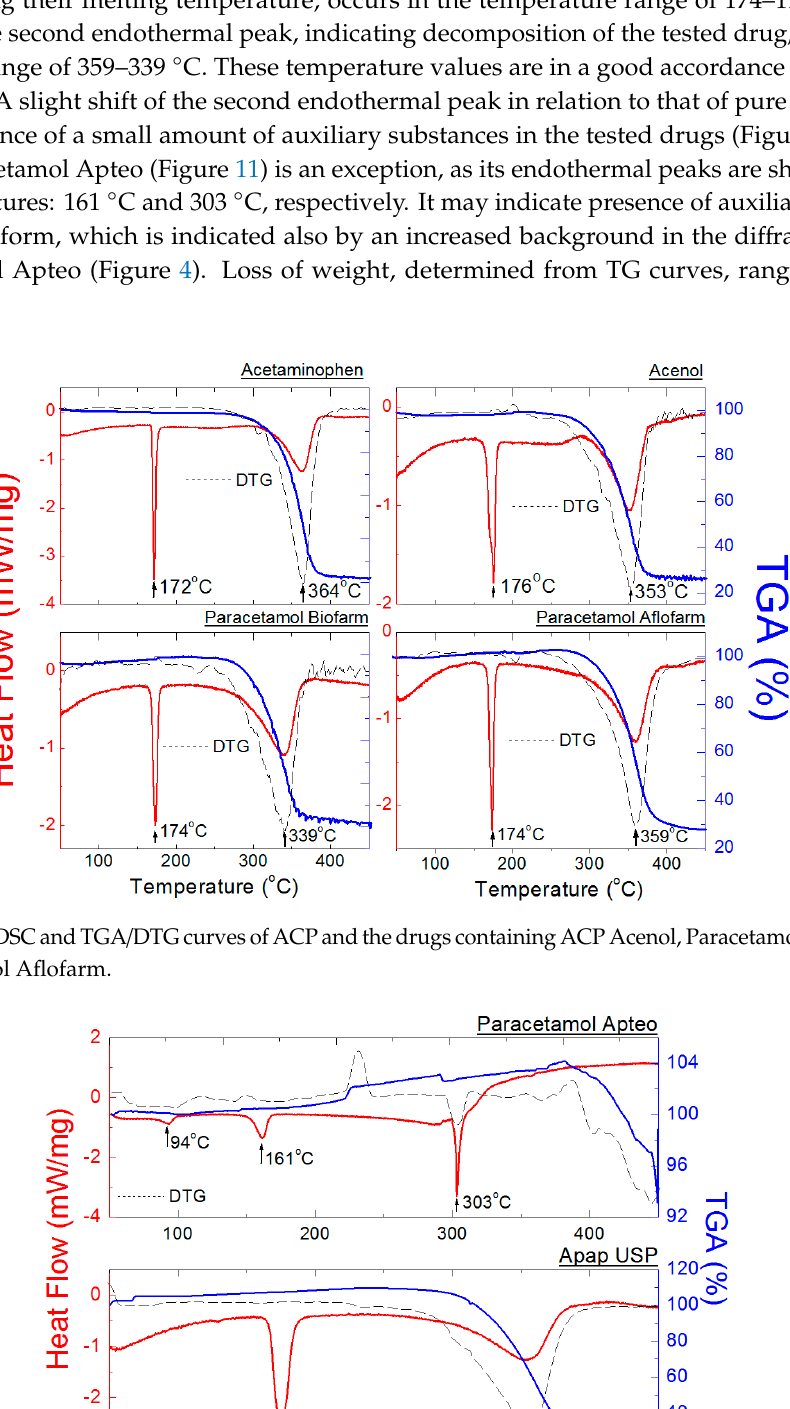
Figure 11. DSC and TGA/DTG curves of the drugs containing ACP Paracetamol Apteo and Apap USP.